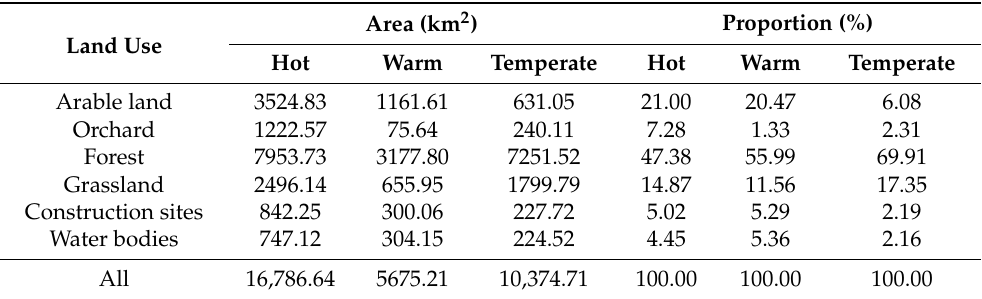
Table 3. Areas and proportions of land use types in dry valleys of Southwest China. Land